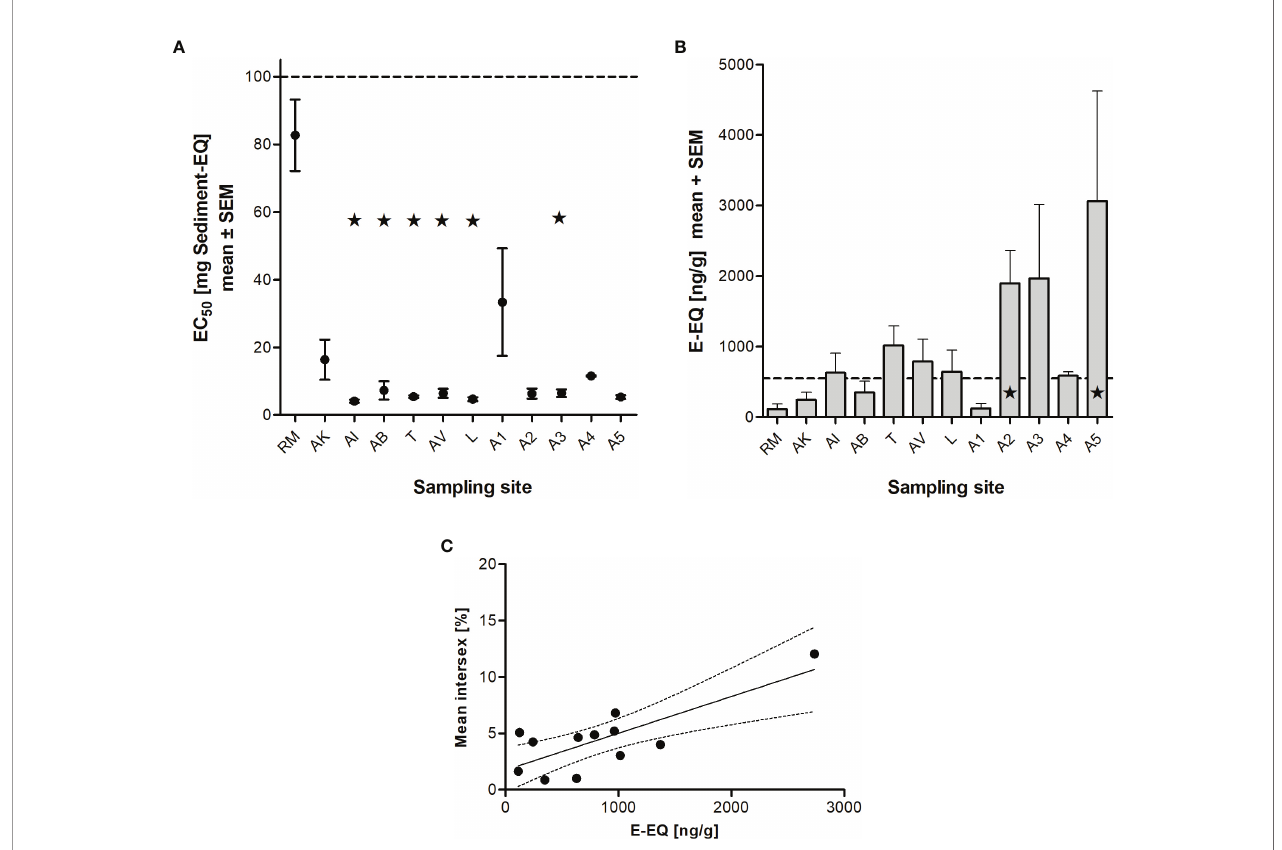
FIGURE 4 | Unspeci fi c and speci fi c toxicity of sediment samples collected in NW-Brittany, France (2012-2020). Microtox assay, expressed as EC 50 values (mean ± SEM) (A) , estrogenic potential, expressed as estradiol equivalents (EEQ) from sediment extracts (limit of quanti fi cation (LOQ) 549 ng/g EEQ) (B) , and relationship between the mean intersex incidence and the estrogenic potential (YES) of sediments (p < 0.01, Pearson r = 0.779) (C) . Statistically signi fi cant differences to reference RM are marked by asterisks (* = p < 0.05; Kruskal-Wallis Test with Dunn ’ s Multiple Comparison-Test). For abbreviations of the sampling sites see Table 1